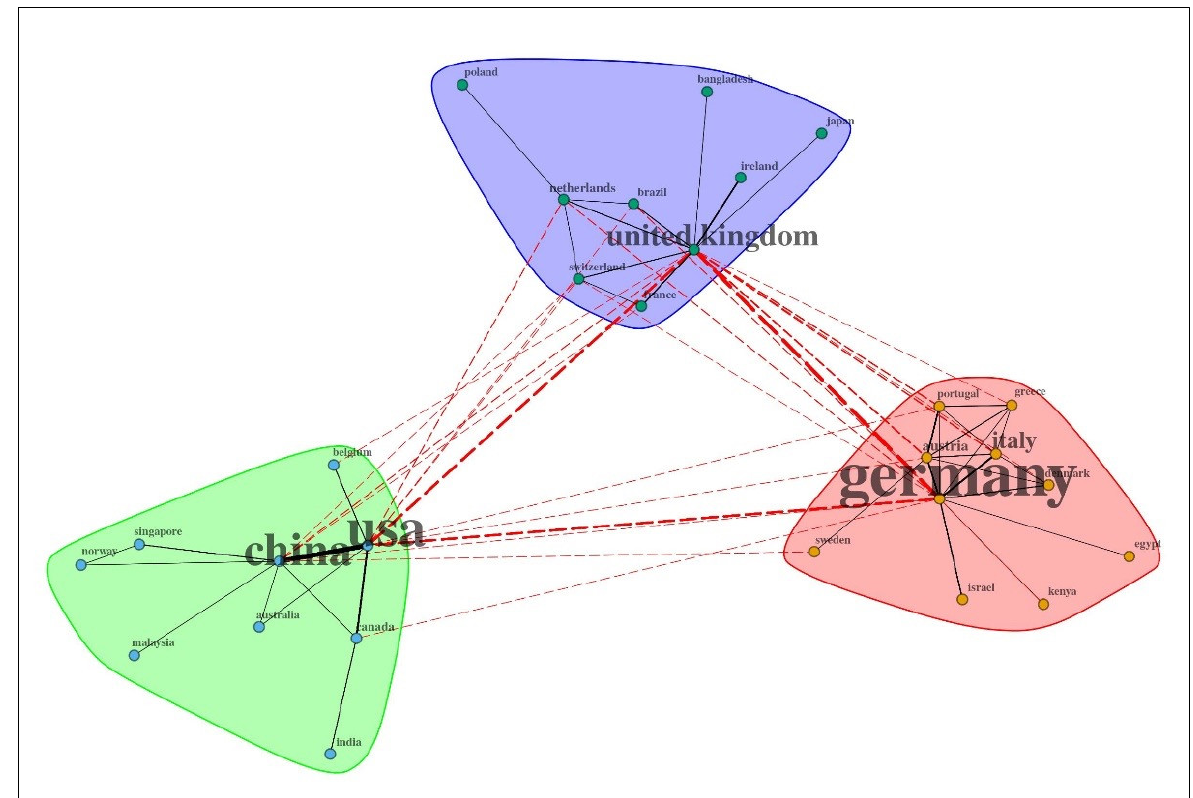
Figure 5. Collaboration network among all the non-isolated countries (88) involved in the production of the documents of the Open Street Map dataset. The leading countries are highlighted. A complete list is given in Table S5.